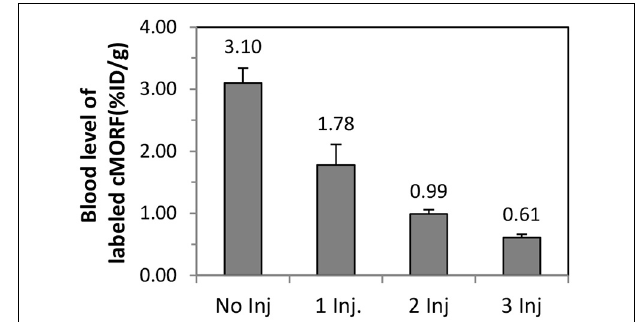
FIGURE 3 | The blood radioactivity levels after the injection of the biotin-Ab-MORF, different numbers of injections of avidin, and the injection of the radiolabeled cMORF. The time of euthanization was at 4 days after initial injection of the pretargeting antibody and 3h after injection of radiolabeled cMORF (see Materials and